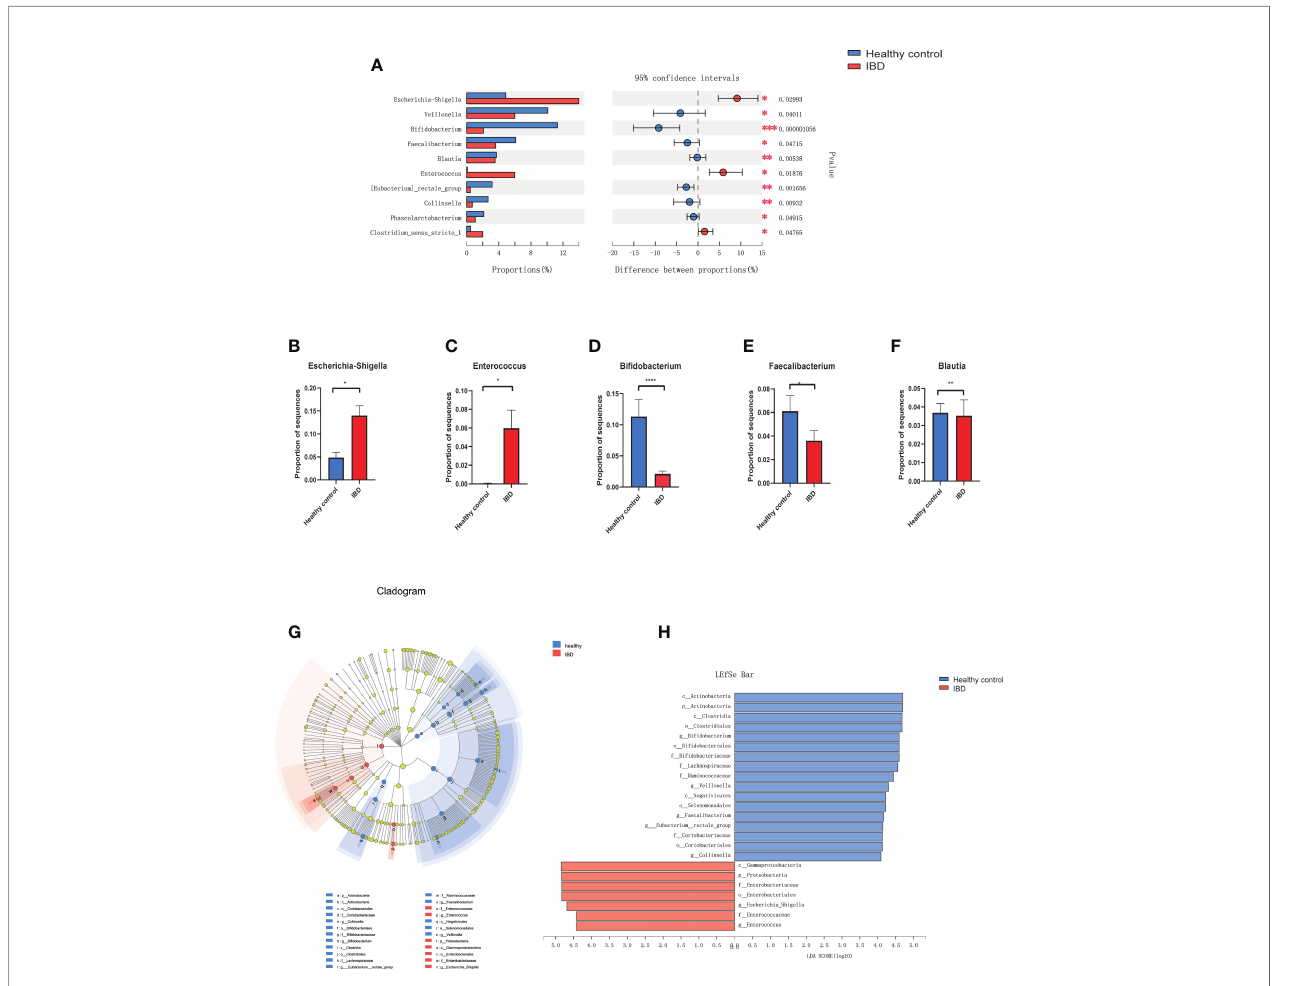
FIGURE 2 | Microbiome alterations at the genus level in IBD. (A) The relative abundance of 10 genera were signi fi cantly different between IBD (n=66) and healthy controls (n=27) after correcting for confounding variables. (B – F) showed the difference of Bi fi dobacterium, Escherichia-Shigella, Enterococcus, Faecalibacterium , and Blautia between IBD and healthy control. (G) Cladogram generated by Lefse analysis showing enriched taxa between the IBD and healthy controls; (H) LDA scores of enriched taxa from G (LDA>4). (*p<0.05, **p<0.01, ***p<0.001, ****p<0.0001). Linear discriminant analysis (LDA); LDA effect size algorithm